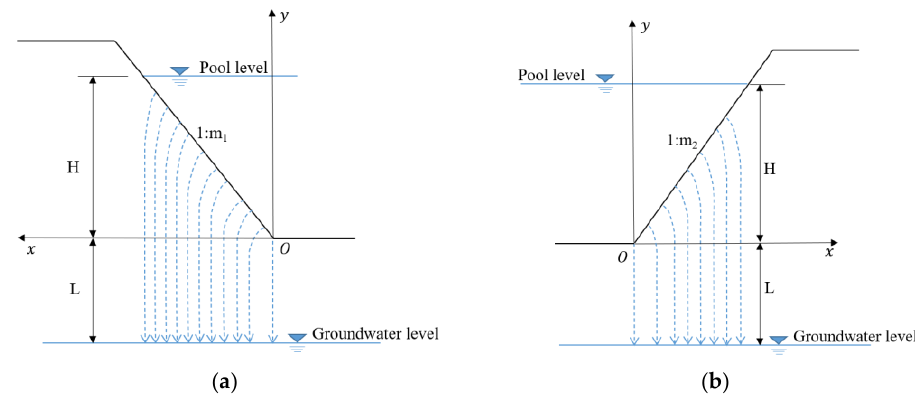
Figure 9. Calculation of leakage from the reservoir periphery. ( a ) Left side. ( b ) Right side.